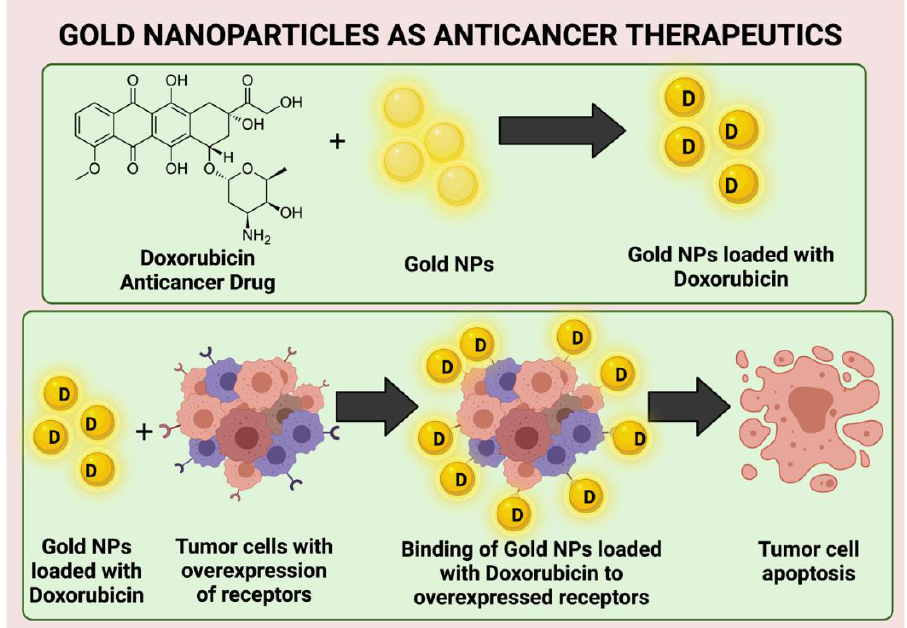
Figure 3. Coupling of anticancer molecules to gold NPs followed by their administration causing tumor cell apoptosis (created using Biorender.com, accessed on 10 January